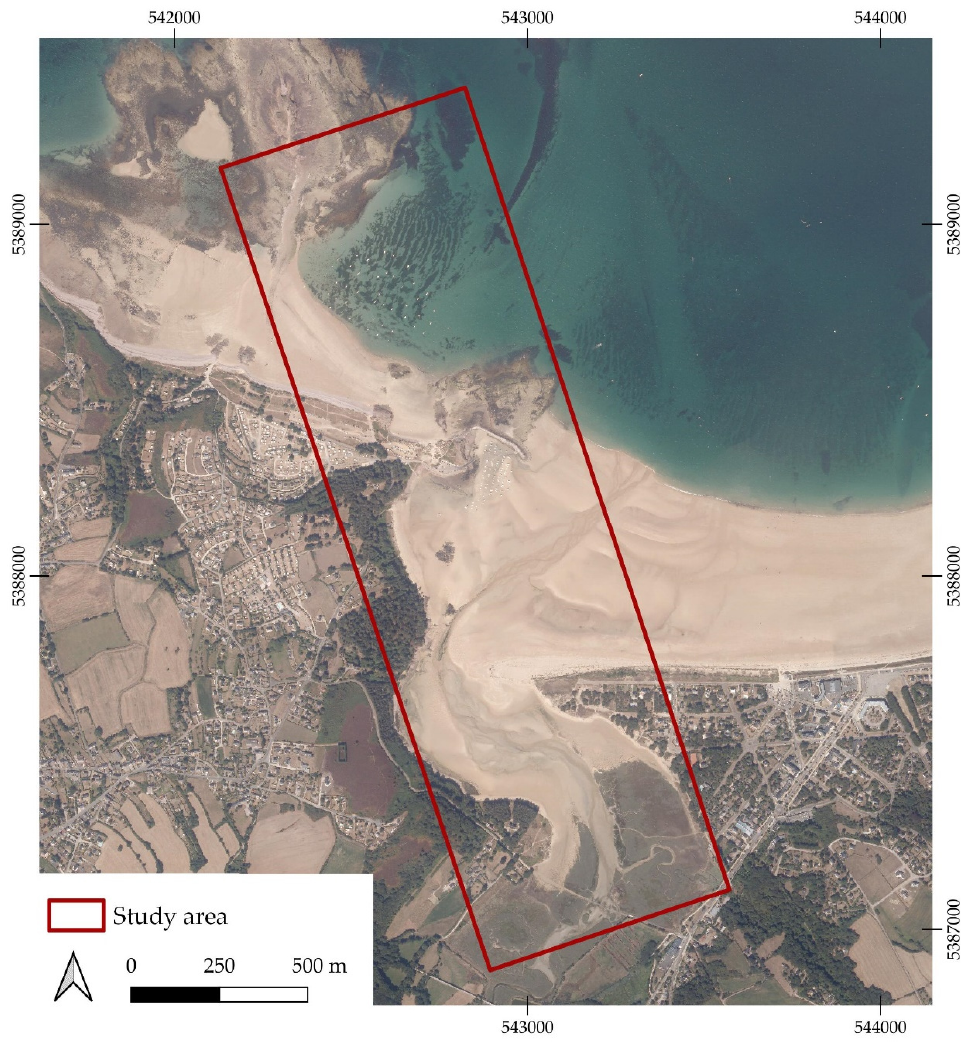
Figure 1. Study area (datum: WGS 84; projection: UTM 30N).